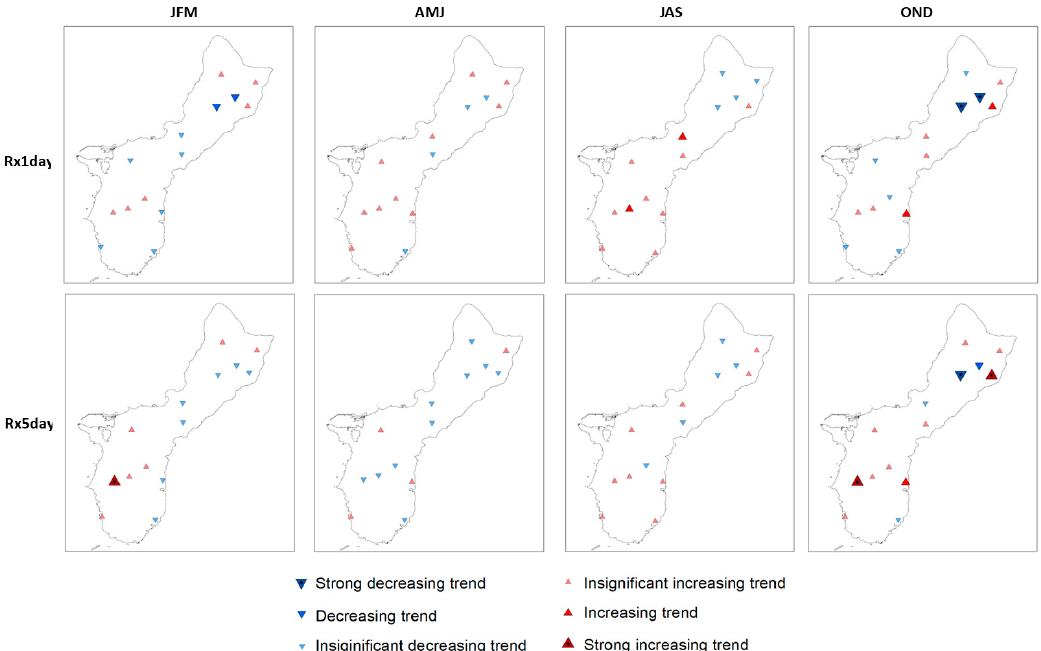
Figure 7. Spatial distributions of seasonal trends of the extreme rainfall indices: the maximum 1-day precipitation (Rx1day, mm) and the maximum 5-day precipitation (Rx5day, mm). Columns represent each season, and rows represent each index.